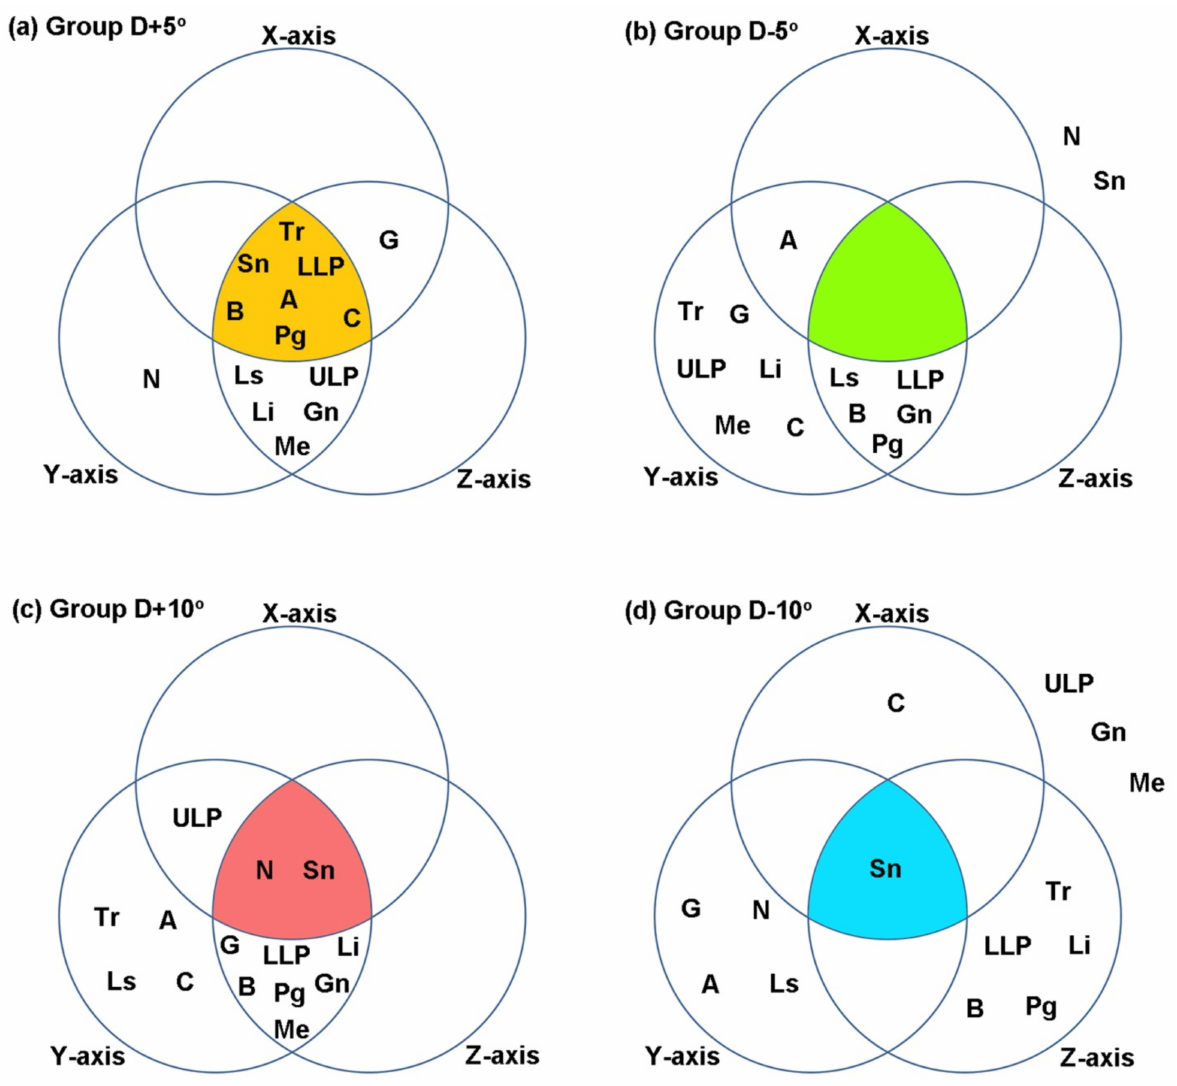
Figure 5. Diagrams for landmarks having no difference with Group D − 0 ◦ in each axis: ( a ) Group D+5 ◦ ; ( b ) Group D − 5 ◦ ; ( c ) Group D+10 ◦ ; ( d ) Group D − 10 ◦